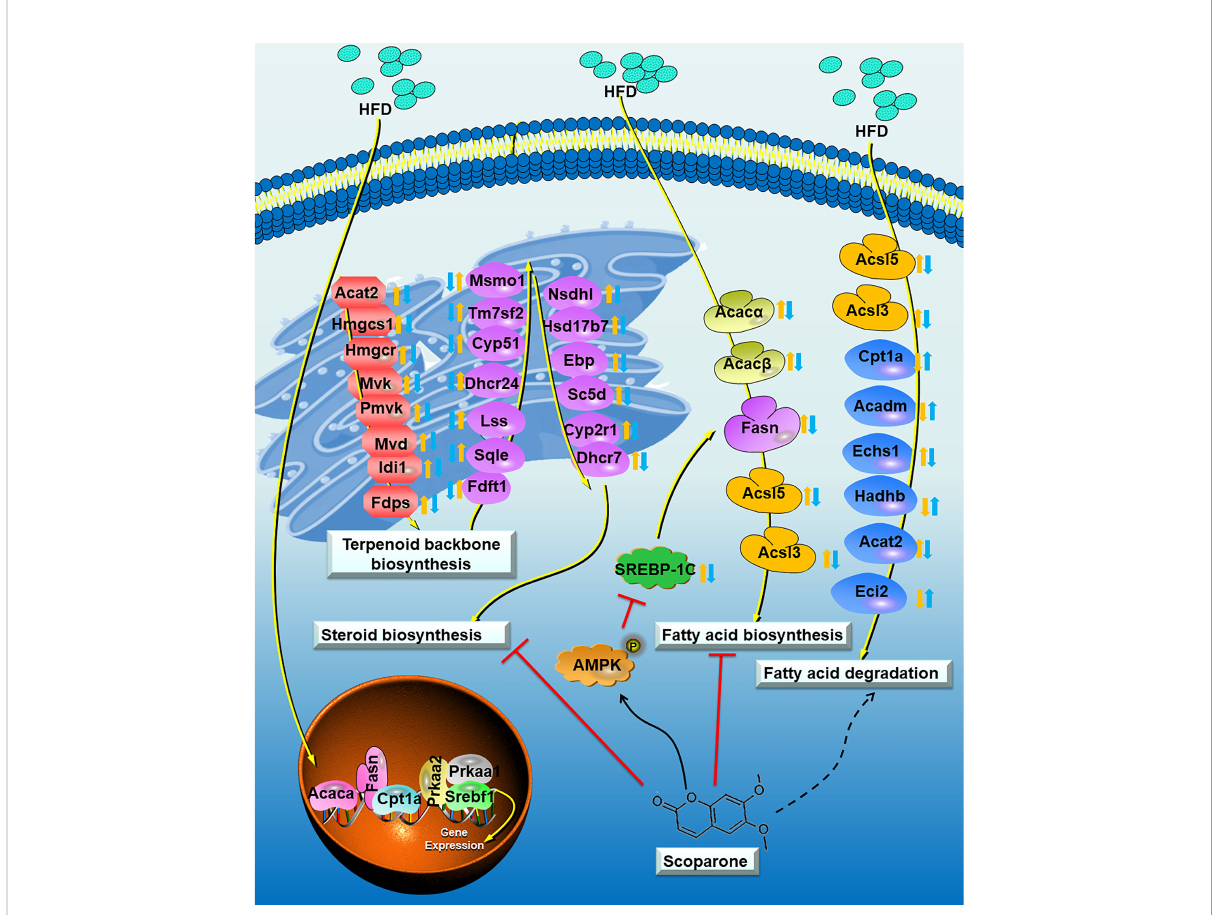
FIGURE 8 Proposed model depicting the process of cholesterol metabolism and fatty acid (triglyceride) metabolism in NAFLD mouse, and the underlying mechanisms of SCO in improving NAFLD. The Control group vs the HFD group: up-regulated:; down-regulated:. The HFD group vs the HFD + SCO group: up-regulated:; down-regulated:. Dashed arrows indicate that SCO may inhibit or promote the expression of these